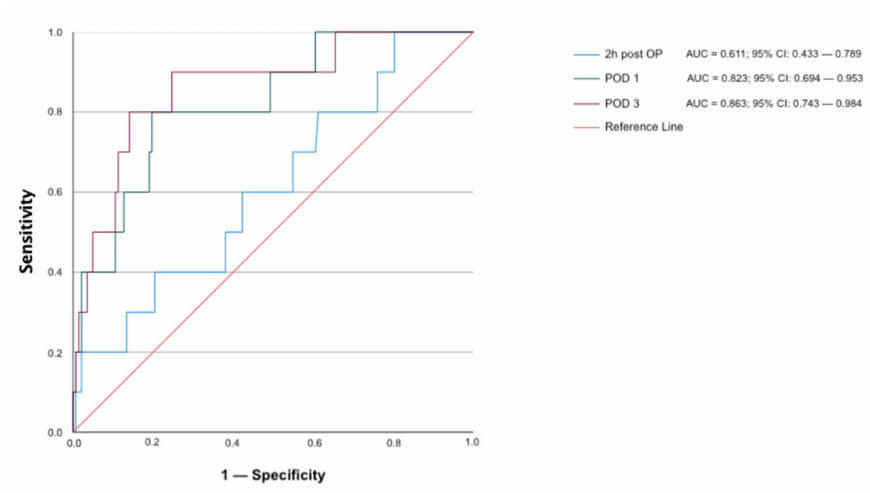
Figure A3. Receiver–operator characteristic curves for cardiovascular complications within 30 days after surgery and Copeptin concentrations at baseline (blue), within two hours after surgery (green), on the first postoperative day (red) and on the third postoperative day (orange). 2 h post OP, within two hours after surgery; AUC, area under the curve; CI, confidence